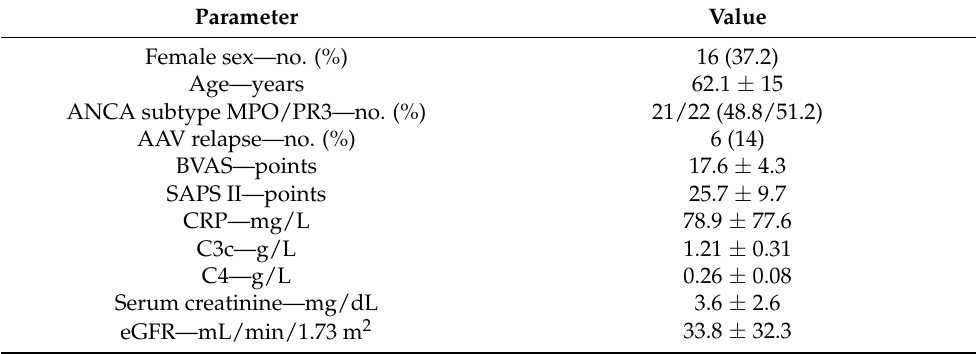
Table 1. Clinical and laboratory parameters of the total cohort of ANCA-associated renal vasculitis. Parameter Value Female sex—no. (%)